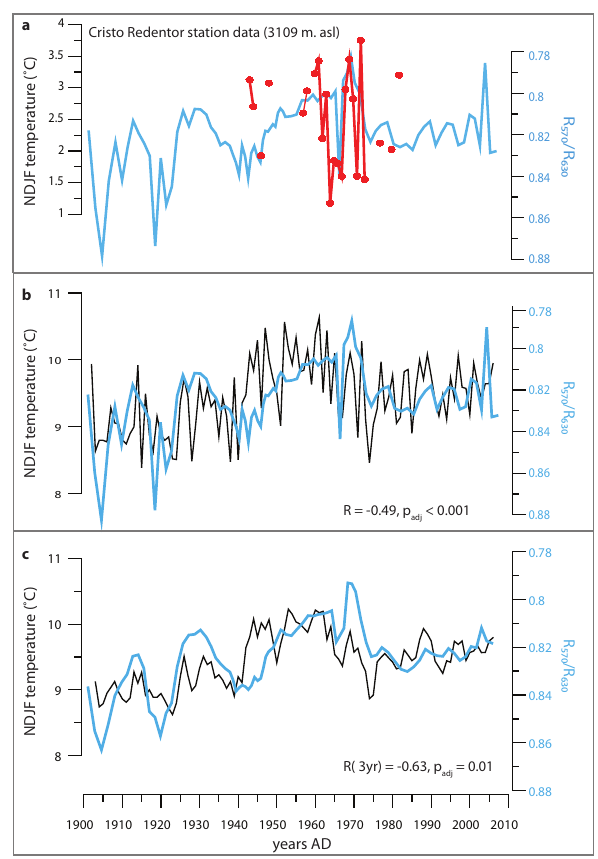
Fig. 4. This figure shows the data used for the calibration model. (a) compares the measured lithogenic content in the core ( R 570 / R 630 ) to meteorological station data (NDJF temperatures) from high altitude Cristo Redentor, for which only few complete NDJF mean temperature data points are available. However, the good match confirms the interpretation of the lithogenic content as a strong proxy for summer temperatures at high altitudes. The final calibration model was based on the high and significant correlation between the lithogenic content of the core and NDJF temperatures from reanalysis data (Mitchell and Jones, 2005). These are shown in (b) for unfiltered, and (c) 3yr-filtered